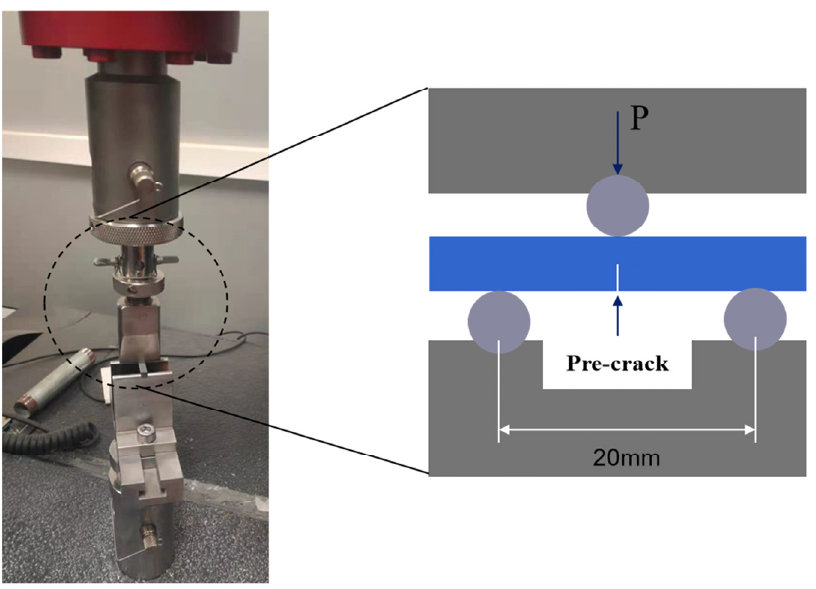
Figure 4. SEM images of Vickers indentation of ceramic materials after healing at 700 °C for ( a ) 30 min, ( b ) 90 min, ( c ) 180 min and ( d ) 300 min.